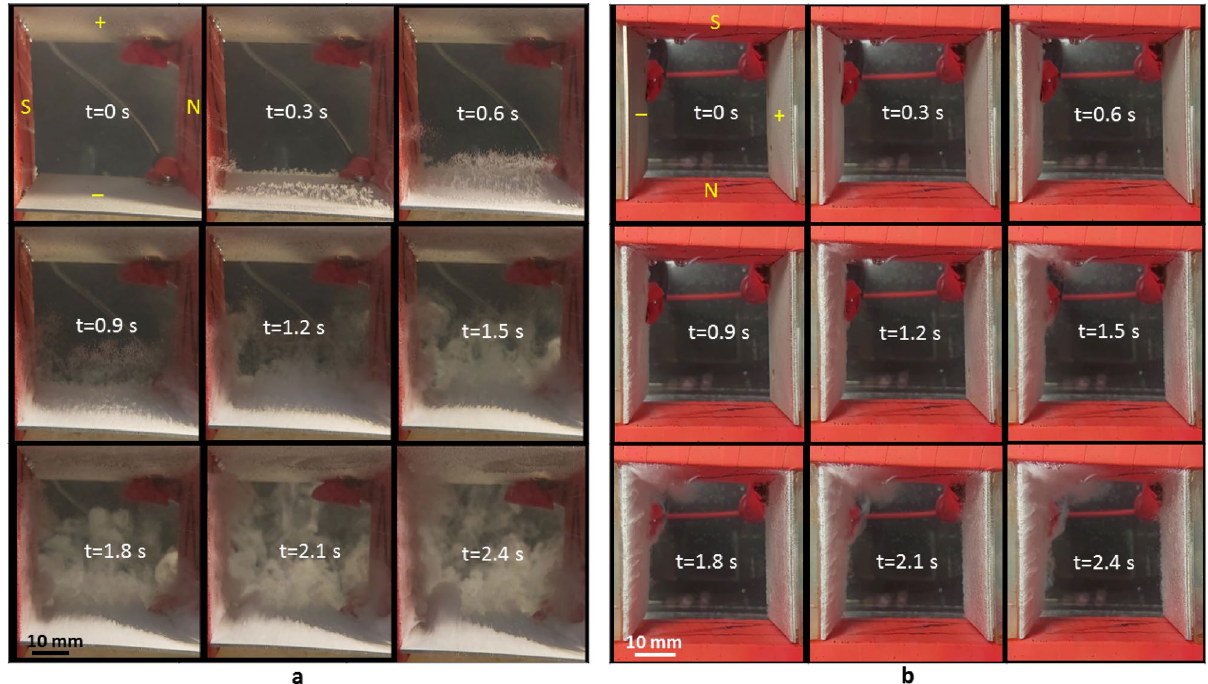
Figure 5. Locomotion of gas bubbles under the effect of a horizontal Lorentz force using a different experimental layout. ( a ) Sequential images of the oxygen and hydrogen bubbles that are detached from the upper and lower platinum electrode, respectively. The experimental layout is shown in Fig. 1c. The N-pole and S-pole of the magnet are at the right and left sides, respectively, for the electrical current of 5 A. ( b ) Sequential images of oxygen and hydrogen bubbles that are detached from the right and left platinum electrodes, respectively. The experimental layout is shown in Fig. 1f. The N-pole and S-pole of the magnet are at the lower and upper sides, respectively.